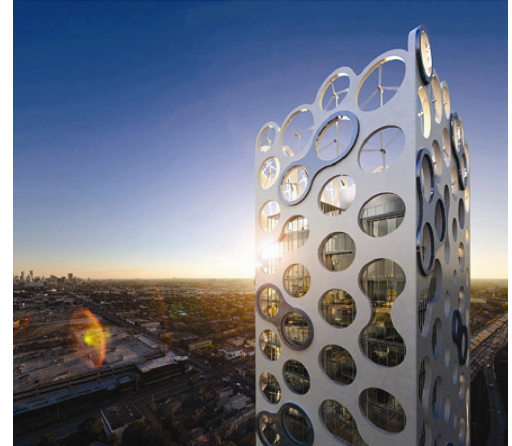
Fig. 1. COR Tower designed for Miami (courtesy of Oppen- heim Architect + Design)